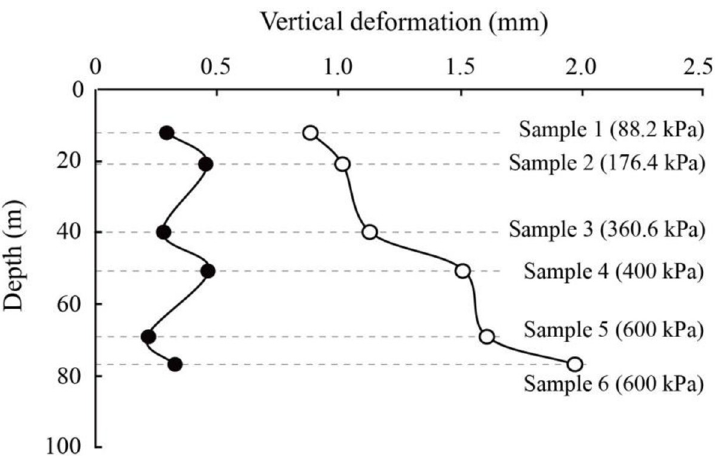
Fig 9. Comparison in vertical deformations under two types of loading, the solid circles represent the deformation in the test, and hollow circles represent the deformation in routine compression test.